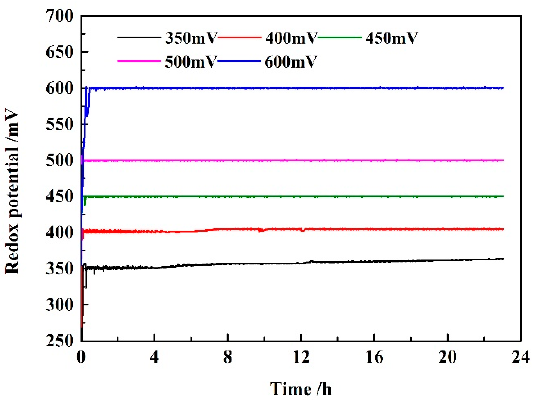
Figure 4. Real-time redox potential data with the redox potential controlling device.